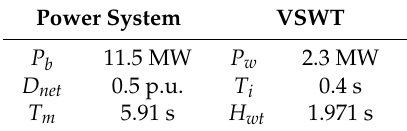
Table A1. Power system and variable-speed wind turbine (VSWT) parameters.